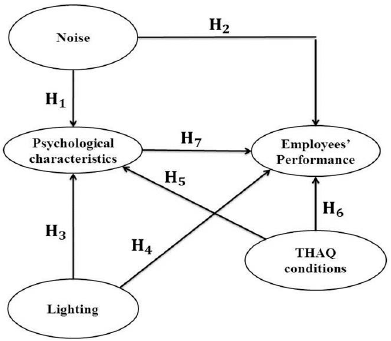
Figure 1. The proposed hypothetical causal model. THAQ, temperature, humidity and air quality.